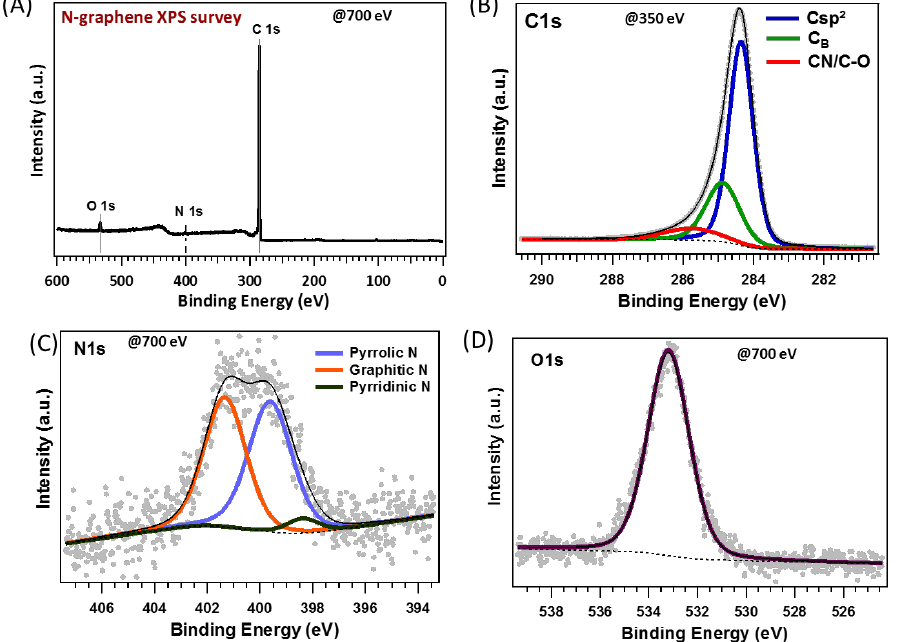
Figure 5. XPS spectra of the N-doped NG-0 graphene film; ( A ) XPS 700 eV overview spectrum; ( B ) XPS 350 eV C1 s core level spectrum; ( C ) XPS 700 eV N1 s core level spectrum; and ( D ) XPS 700 eV O1 s core level